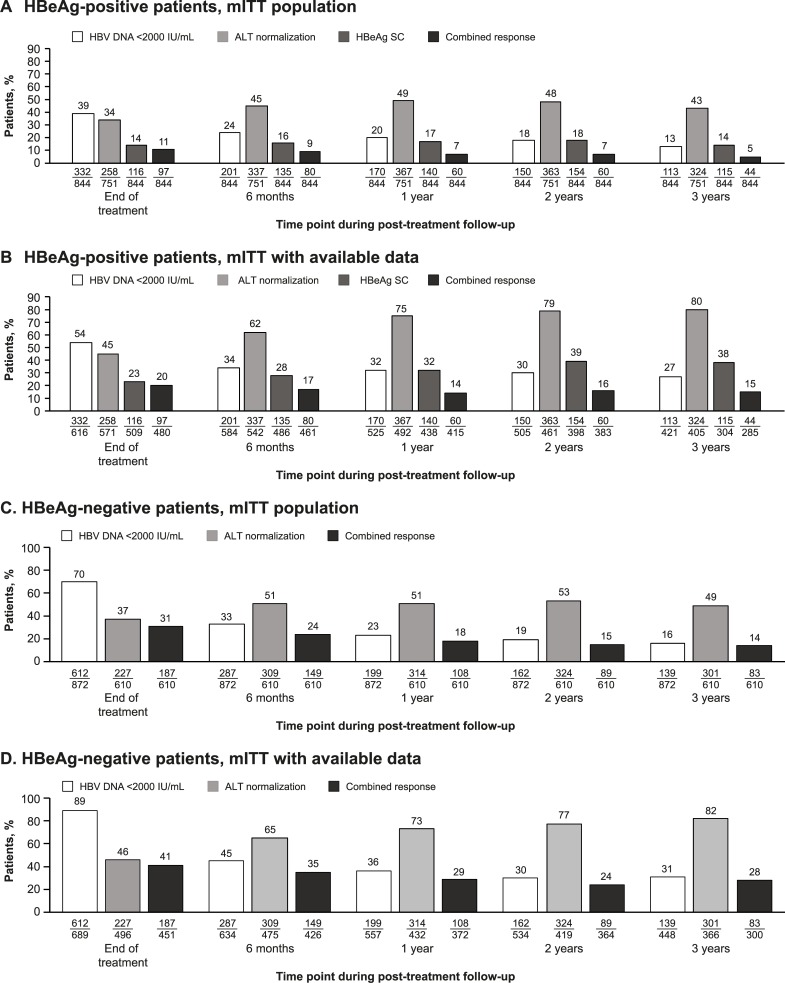
Response rates in HBeAg-positive patients (HBV DNA <2000 IU/mL, ALT normalization, HBeAg seroconversion, and combined responses) and HBeAg-negative patients (HBV DNA <2000 IU/mL, ALT normalization, and combined responses) over time (mITT population and mITT patients with available data).Patients receiving nucleos(t)ide analogs were considered to be non-responders for HBV DNA endpoints at the respective time points. ALT response includes only patients with elevated ALT at baseline. ALT, alanine aminotransferase; HBeAg, hepatitis B e antigen; HBV, hepatitis B virus; mITT, modified intention-to-treat; SC, seroconversion.